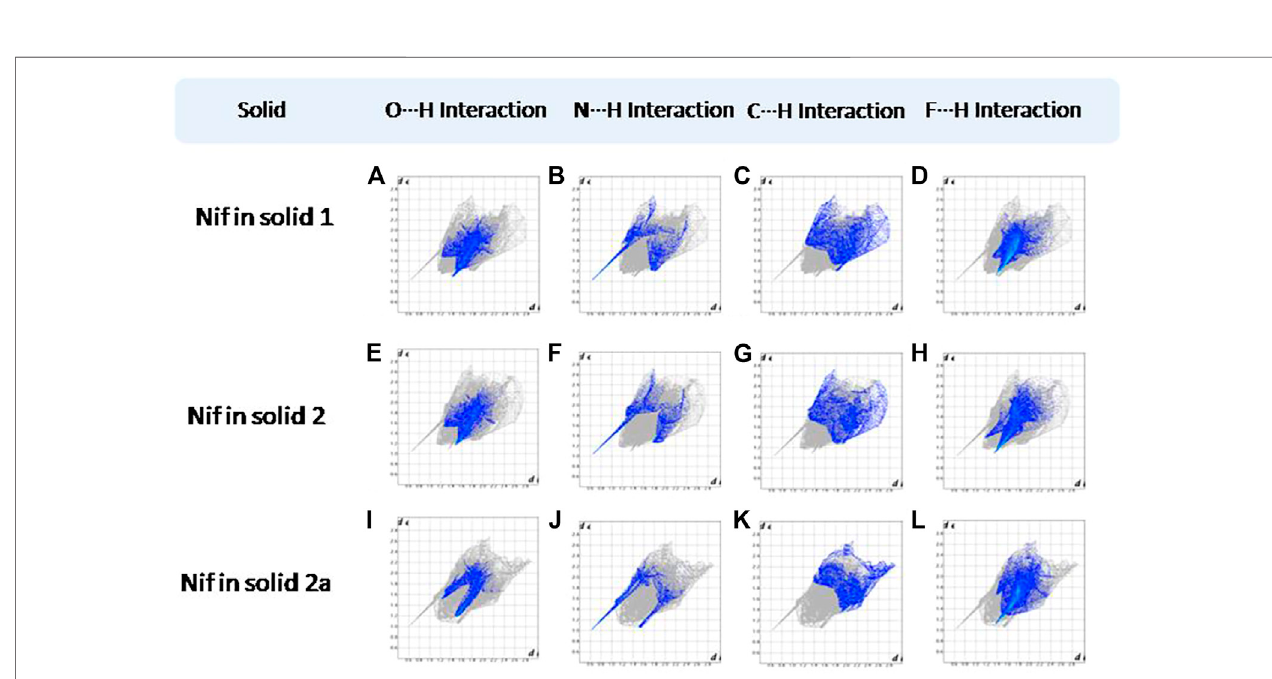
FIGURE 11 | (A,E,H) Hirshfeld surface analysis and structural environment of Nif, Mef I, and Mef II. (B – D) O ··· H/H ··· O, C ··· H/H ··· C, and F ··· H/H ··· F interactions resolved fi ngerprintplotsofNif. (F,G) and (I,J) O ··· H/H ··· OandC ··· H/H ··· Cinteractionsresolved fi ngerprintplotsofbothformsofMef.Thetwospikespresentinthesolids are characteristic of the carboxylic acid